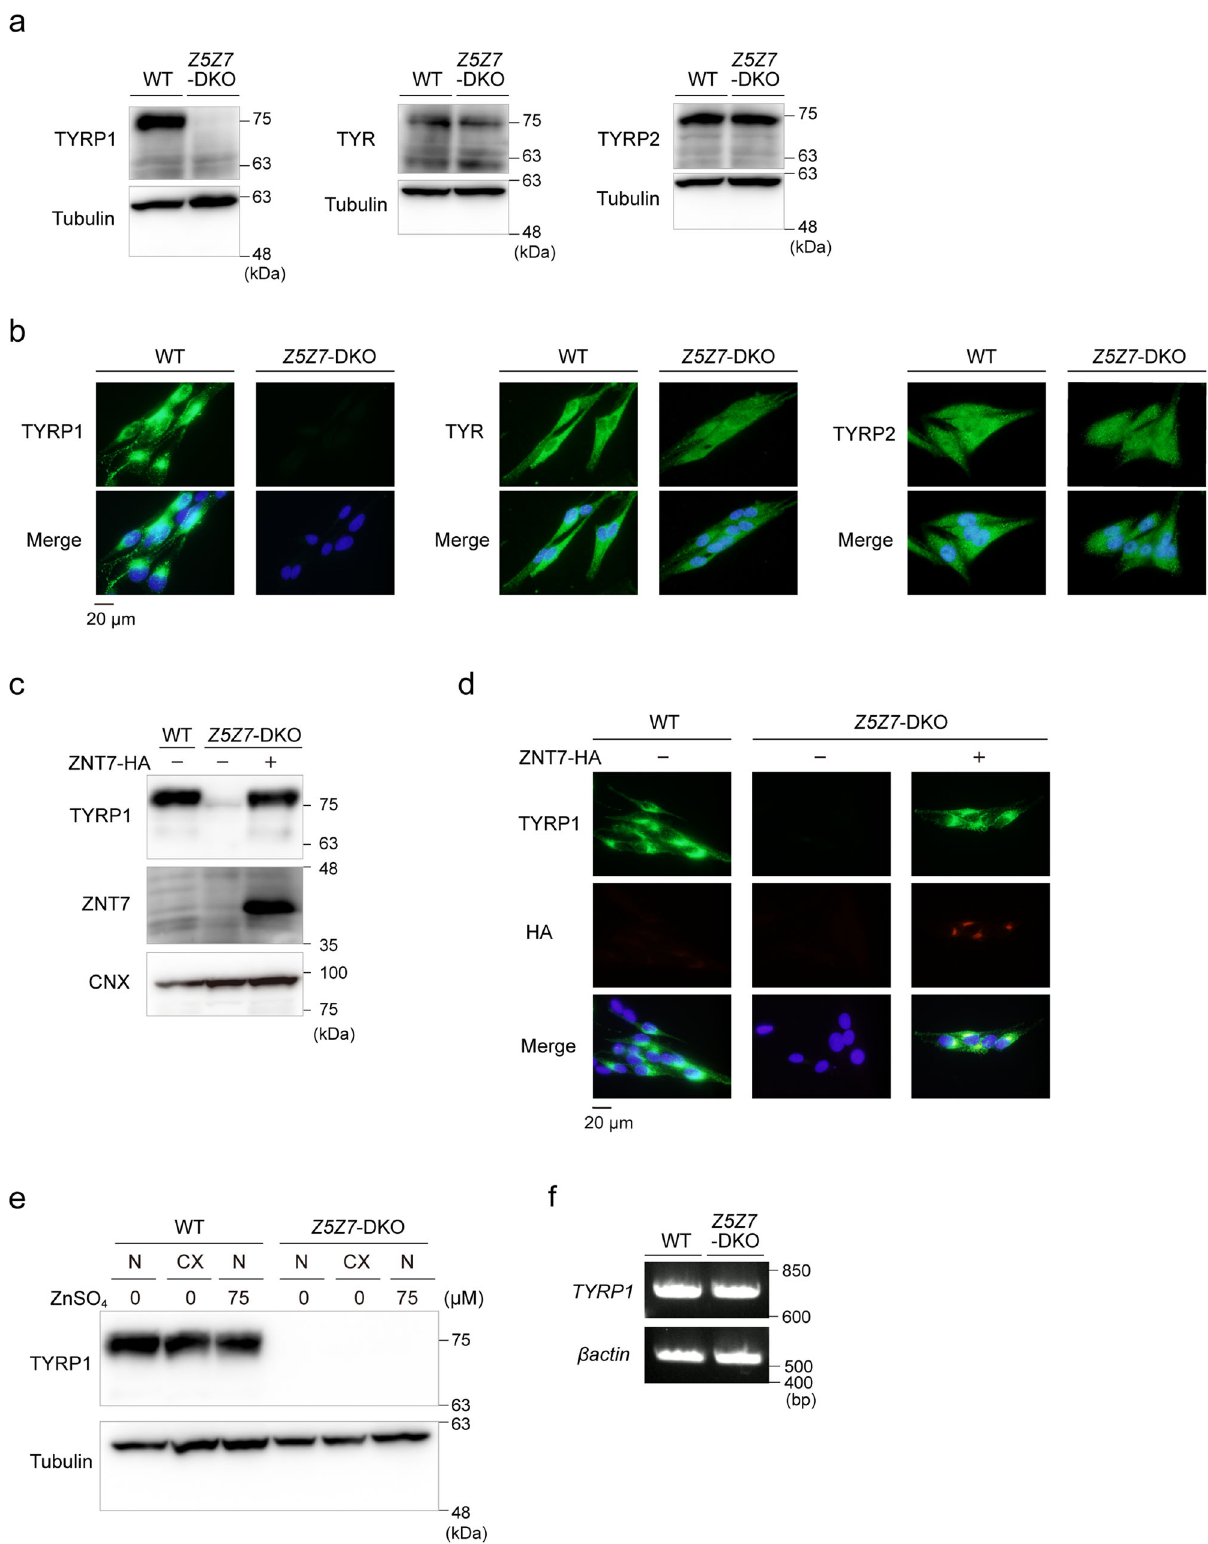
Fig. 3 TYPR1 expression is substantially decreased in Mewo- Z5Z7 -DKO cells. a , b Expression ofTYRP1, but not TYR orTYRP2, was substantially decreased in Mewo- Z5Z7 -DKO cells. Immunoblotting ( a ) and immuno fl uorescence staining ( b ). c , d Expression of TYRP1 in Mewo- Z5Z7 -DKO cells was reversed by stable re-expression of ZNT7. Immunoblotting ( c ) and immuno fl uorescence staining ( d ). e Effects of zinc status on the expression of TYRP1. Wild-type (WT) MewoandMewo- Z5Z7 -DKOcells were culturedin normalmedium(N), normal medium supplementedwithZnSO 4 (75 μ M), or inzinc-de fi cient medium (CX) generated using Chelex-treated FCS for 24h. f TYRP1 mRNA levels were not decreased in Mewo- Z5Z7 -DKO cells. In a , c , and e , Tubulin or CNX was detected as a loading control. Each experiment was performed at least three times, and representative results from independent experiments are shown.